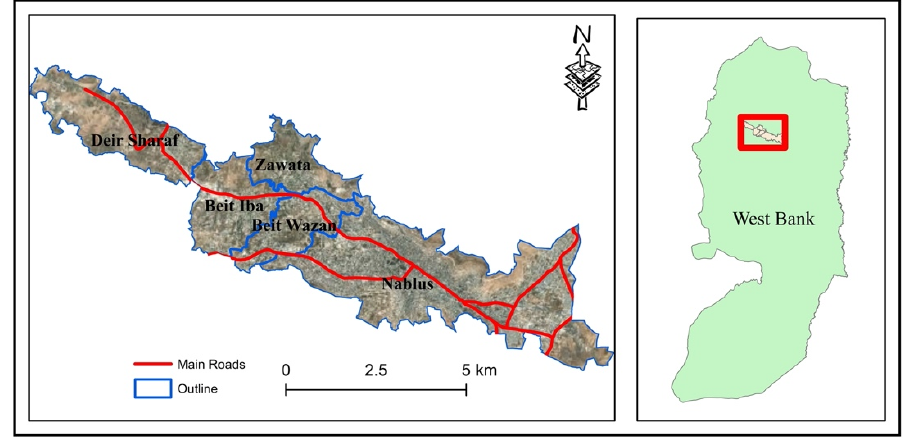
Figure 1. Location of the study area.